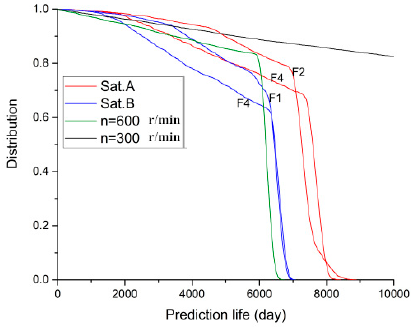
Figure 17. Distribution of the minimum residual life.